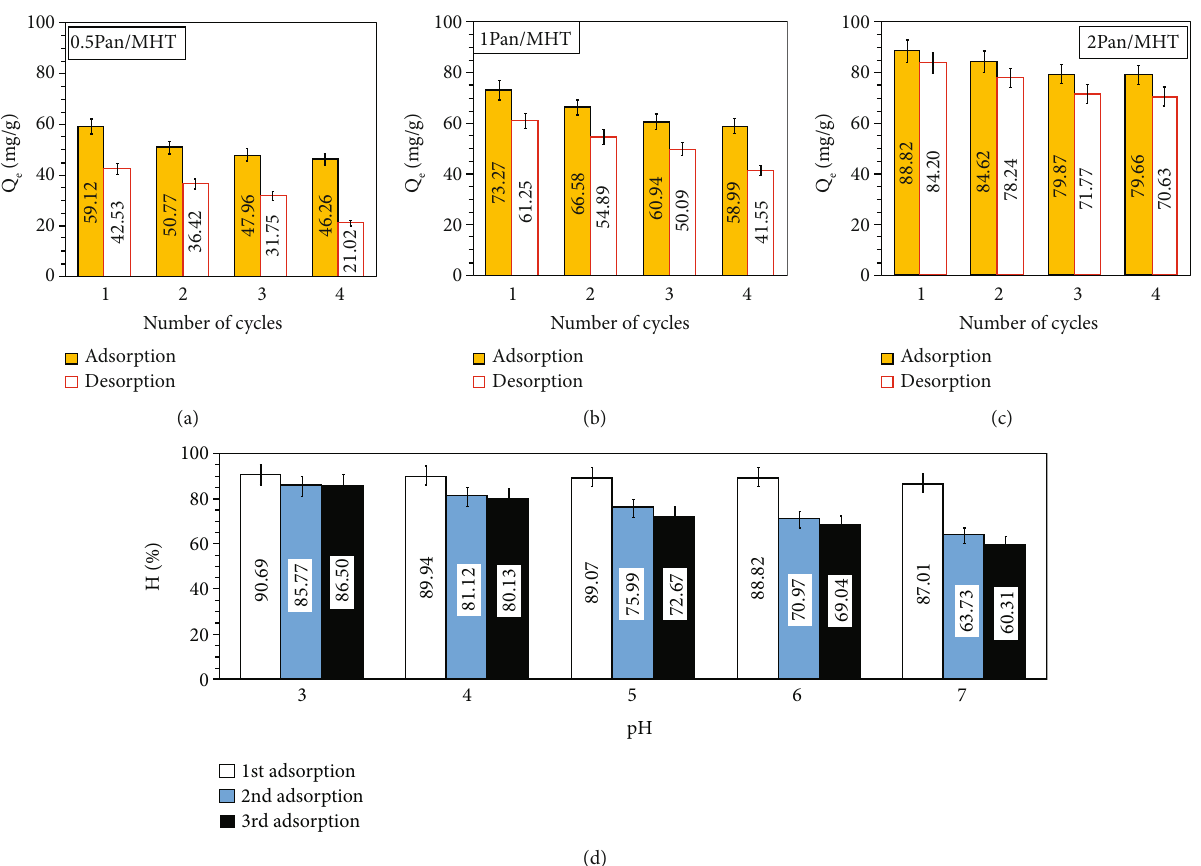
Figure 16: MO adsorption and desorption cycles with 0.5 Pan/MHT (a), 1 Pan/MHT (b), 2 Pan/MHT (c), and the e ff ect of solution pH on the reusability of 2 Pan/MHT for MO adsorption